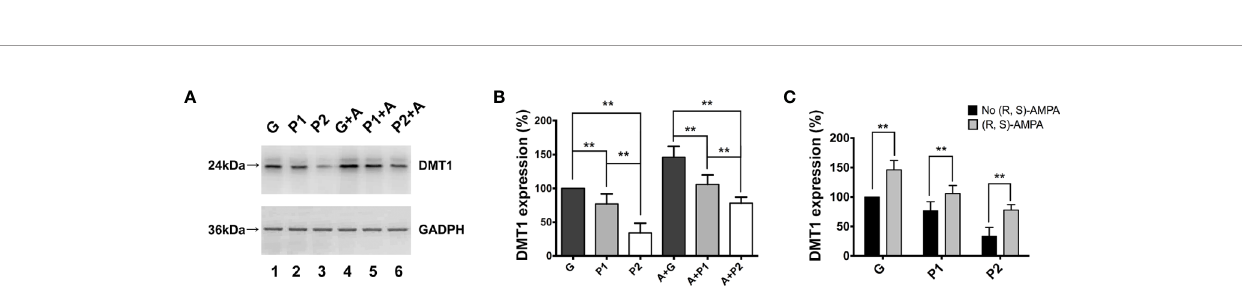
FIGURE 4 | (R, S)-AMPA was incubated with tumor cells in vitro to con fi rm the relationship between Ca 2+ -permeable AMPA receptors and DMT1. (A) Western blotting result showed expression of DMT1 in glioma cells in vitro . (B, C) Quanti fi cation of DMT1 expression. Data are presented as mean ± SD (n = 6/group). **P < 0.01. Groups: S, sham; G, glioma; P1 and P2, propofol 1.2, and 4.4 µg/ml -1 , respectively; A, (R, S)-AMPA. AMPA, a -amino-3-hydroxy-5-methyl-4- isoxazolepropionic acid; DMT1, divalent metal transporter 1.